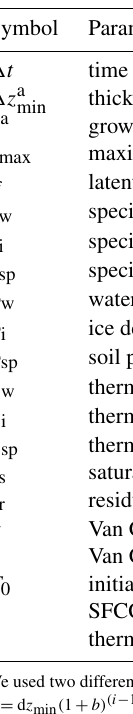
Table G2. Summary of the mean number of iterations for the NCZ algorithm, the Newton–Raphson algorithm (N. R.), and the globally convergent Newton algorithm (g. c. N.). The simulation lasts 1 year with a time step (cid:49)t = 1h. We considered different spatial discretizations. The tolerance ε = 10 × 10 − 11 has been rescaled with the water latent heat of fusion and the water density. The maximum number of iteration for each time step is 40. As can be seen the Newton–Raphson and the globally convergent Newton does not converge so it always reaches the maximum number of iterations allowed.